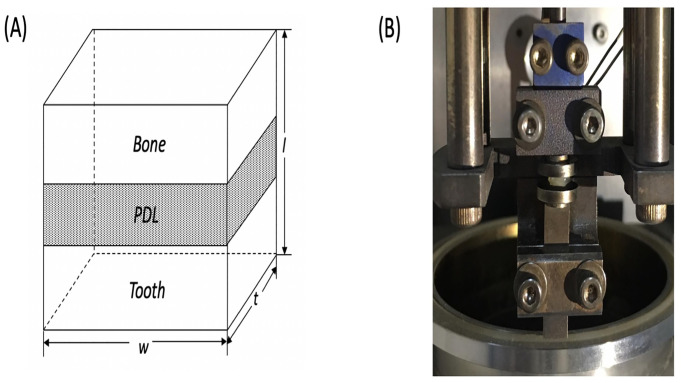
(a) Schematic view of a cube-shaped sample; (b) compressive DMA setup for human PDL.